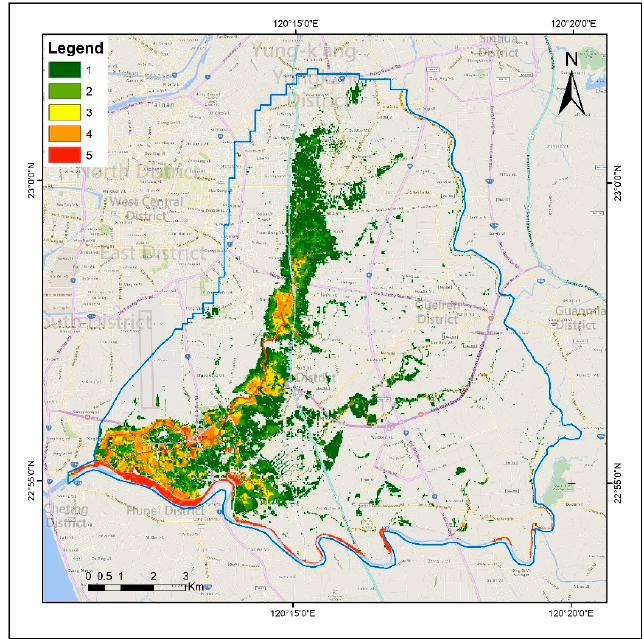
Figure 7 . Risk map in five levels from low (green color) to high (red color) .